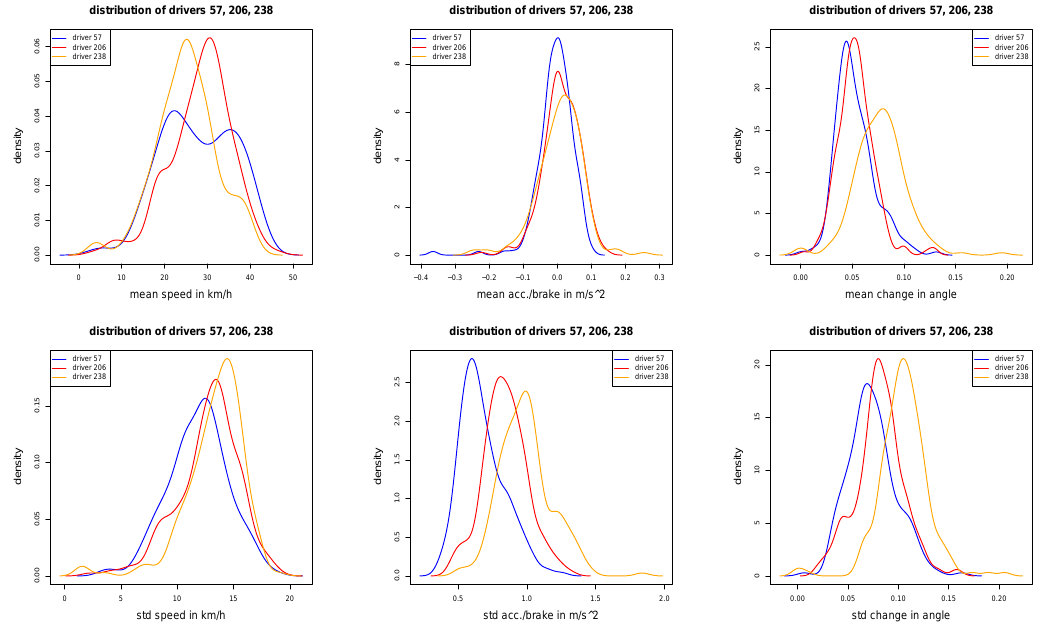
Figure 5. Densities of the individual trip statistics v s , a s and ∆ s ( first row ), and σ v , s , σ a , s and σ ∆ , s ( second row ) for s = 1, . . . , S of the three selected drivers 57, 206 and